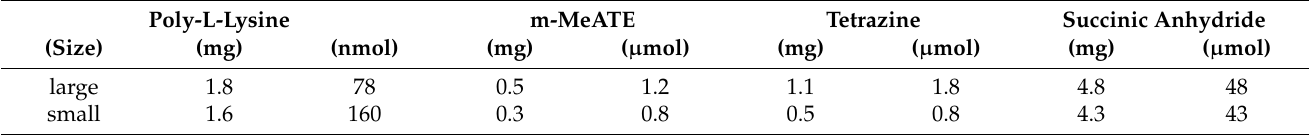
Table 4. Poly-L-lysine (PL) (large: 22.5 and 21 kDa, small: 10 kDa) conjugation conditions for each functional group: N-succinimidyl-3-(trimethylstannyl)-benzoate (m-MeATE), Tetrazine-NHS (Tz), and succinic